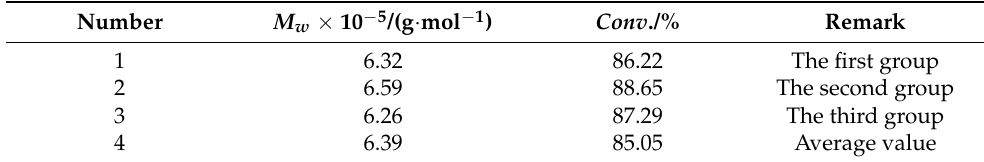
Table 6. Parallel verification of optimum process conditions for temperature factors.